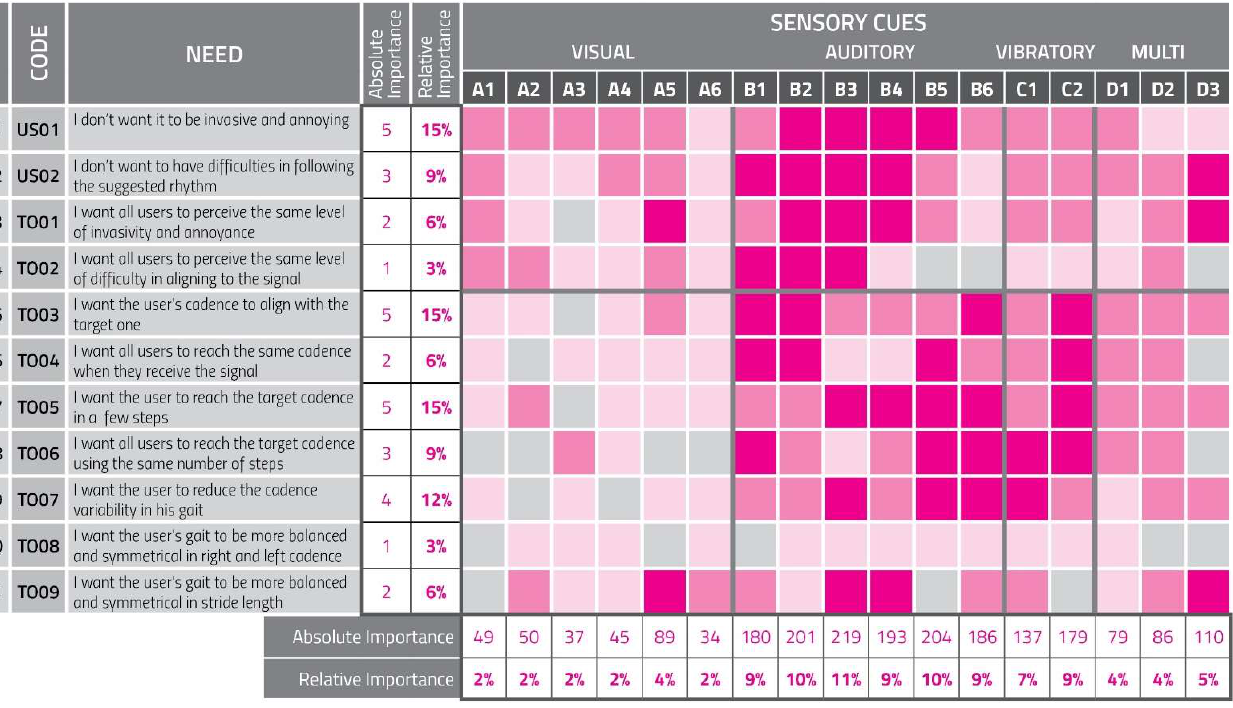
Figure 9. Innovative use of the Quality Function Deployment matrix as a tool to determine the most effective sensory feedback submi(cid:308)ed to the users.